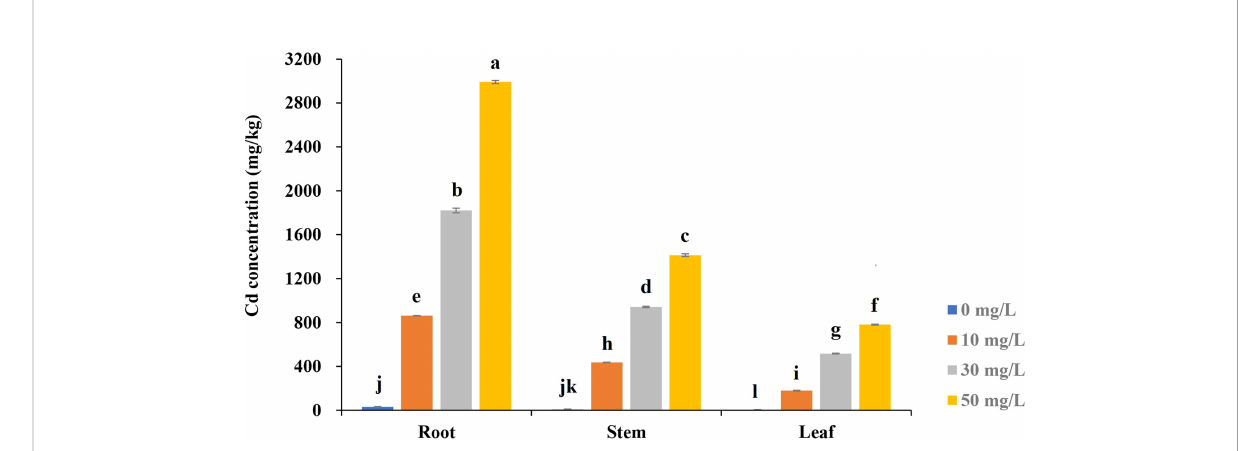
FIGURE 4 The Cd concentration in different tissues of Tartary buckwheat seedling under various cadmium stresses after 7-day treatments. Different lowercase letters on the top of bars indicate signi fi cant differences between treatments according to Duncan t -test ( p -value <